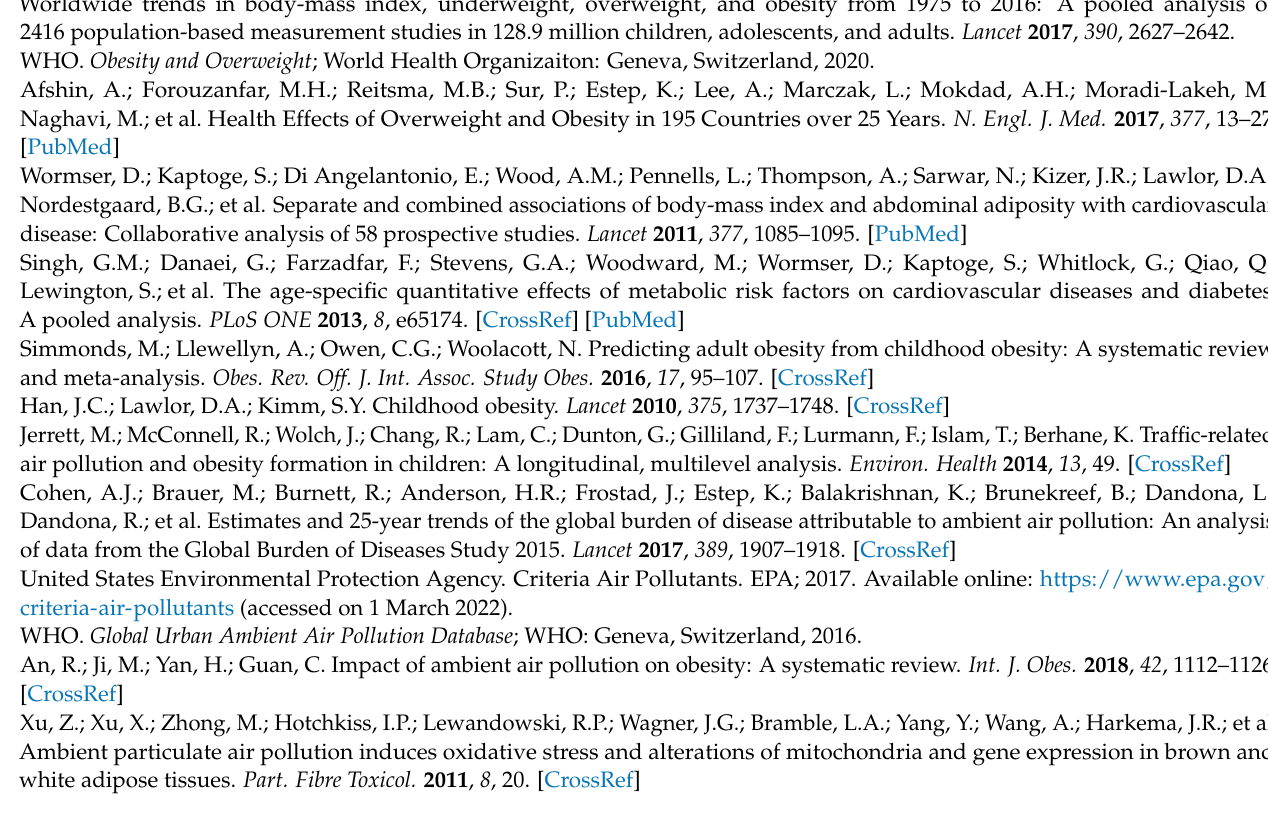
Figure S1: Funnel study in the meta-analysis on the association between PM 10 ( a ), PM 2.5 ( b ), PM 1 ( c ), and NO 2 ( d ) exposure and childhood obesity; Figure S2: Funnel study in the meta-analysis on the association between PM 10 ( a ), PM 2.5 ( b ), and NO 2 ( c ) exposure and childhood BMI status; Figure S3: Sensitivity analysis of PM 10 , PM 2.5 , PM 1 , and NO 2 on childhood obesity; Figure S4: Sensitivity analysis of PM 10 , PM 2.5 , and NO 2 on BMI of children and